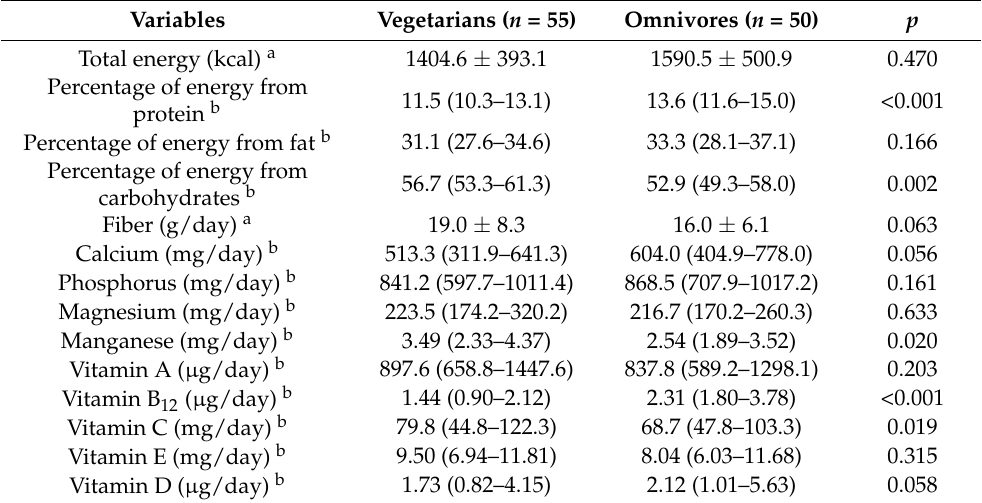
Table 2. Dietary intake of macro- and micronutrients in children on vegetarian and omnivorous diets.